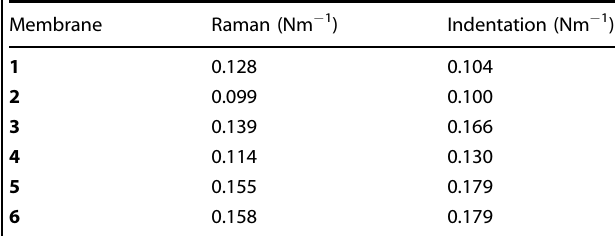
Table 1. Tensions of the pristine graphene membranes calculated from Raman and indentation